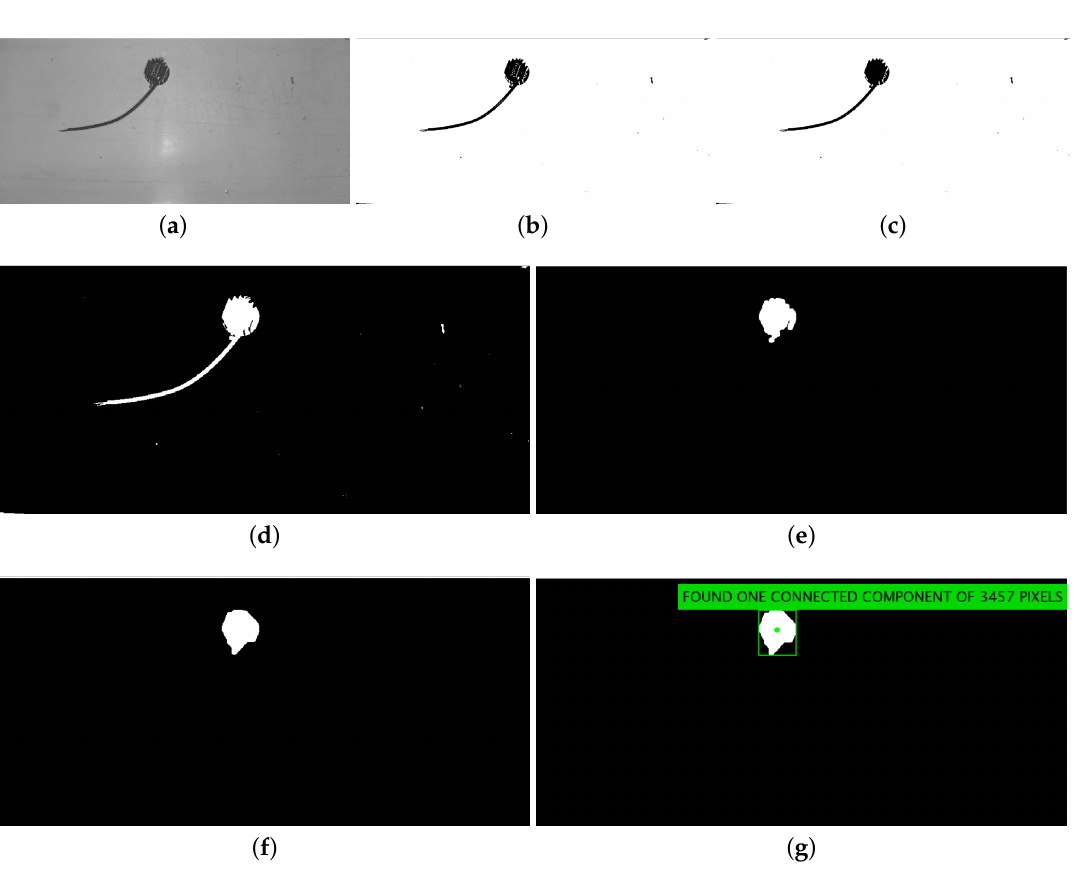
Figure 7. Outcome of the blob-based processing algorithm for the sample frame ( e ) of Figure 5: ( a ) maximum over the colour channels; ( b ) binarization; ( c ) small blobs removed; ( d ) filled complement image; ( e ) morphological opening; ( f ) morphological closing; and ( g ) visualization of the blob